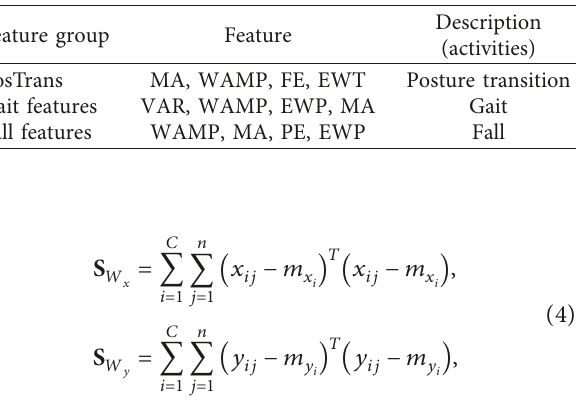
Table 3: Feature groups of posture transition, gait, and fall.